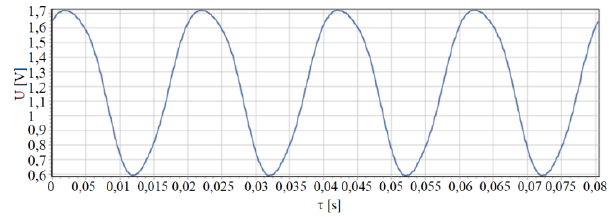
Fig. 7. Synchronous average of the generator phase-to-phase voltage as a function of time for one engine working cycle